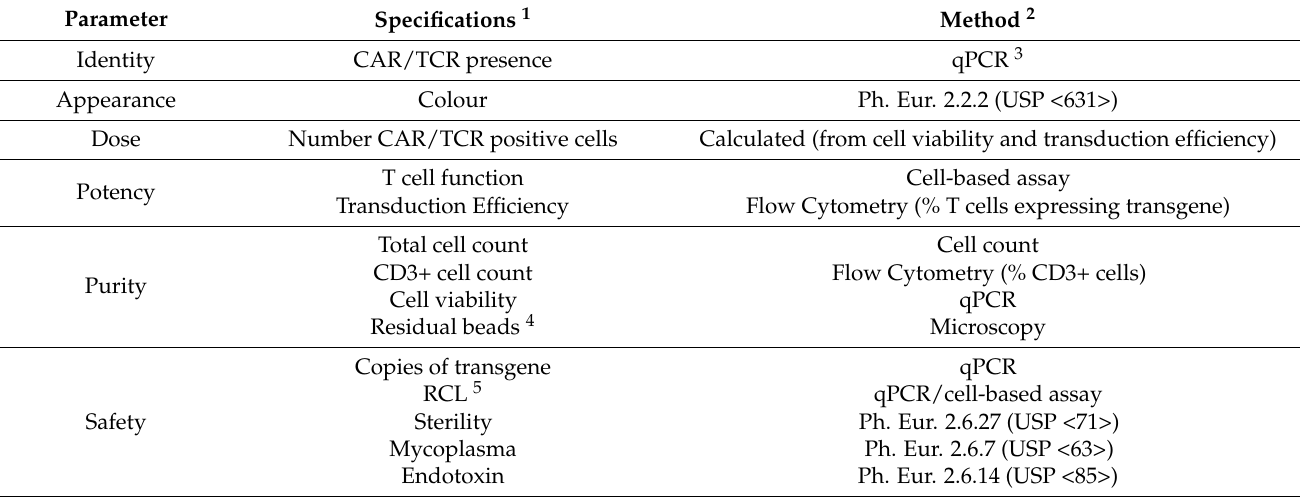
Table 3. Example specifications for T cell drug